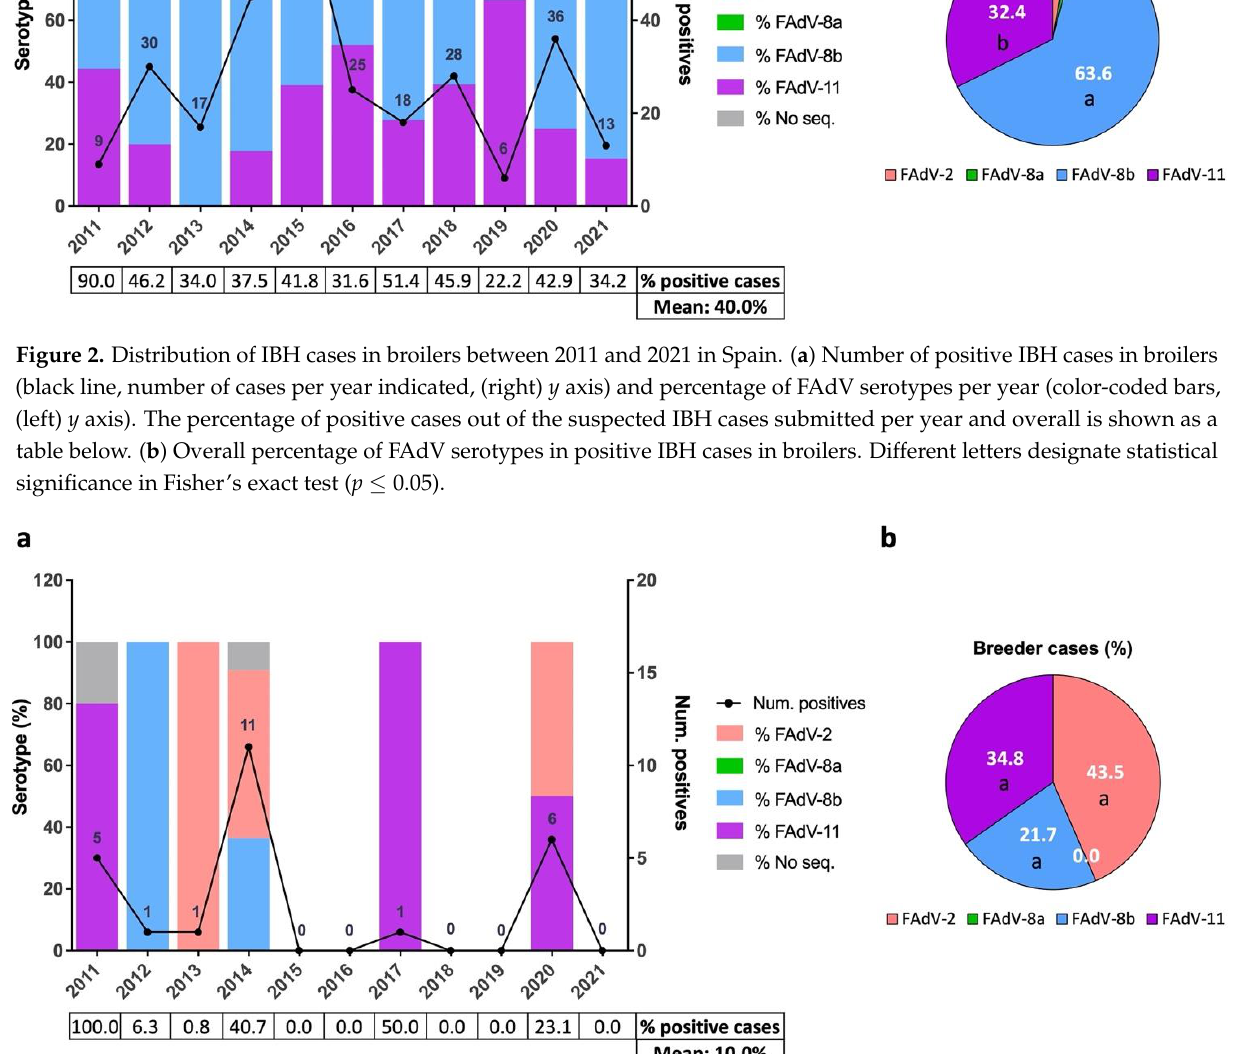
Figure 2. Distribution of IBH cases in broilers between 2011 and 2021 in Spain. ( a ) Number of positive IBH cases in broilers (black line, number of cases per year indicated, (right) y axis) and percentage of FAdV serotypes per year (color-coded bars, (left) y axis). The percentage of positive cases out of the suspected IBH cases submitted per year and overall is shown as a table below. ( b ) Overall percentage of FAdV serotypes in positive IBH cases in broilers. Different letters designate statistical significance in Fisher’s exact test ( p ≤ 0.05).